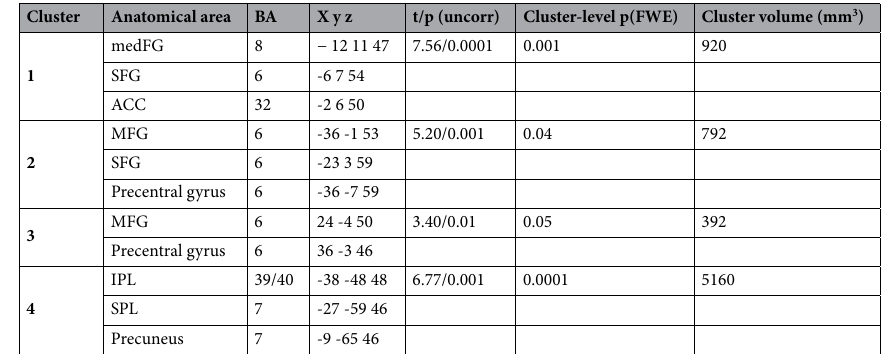
Table 1. Peak activations and anatomical areas of the conjunction analysis (reflecting unity) across all four EF tasks. Thresholded at voxel-level p < 0.005 (uncorrected) and cluster-level p < 0.05 (FWE corrected). MFG middle frontal gyrus, SFG superior frontal gyrus, medFG medial frontal gyrus, ACC anterior cingulate gyrus, IPL inferior frontal gyrus, SPL superior parietal lobe, BA Brodmann’s area, x y z MNI